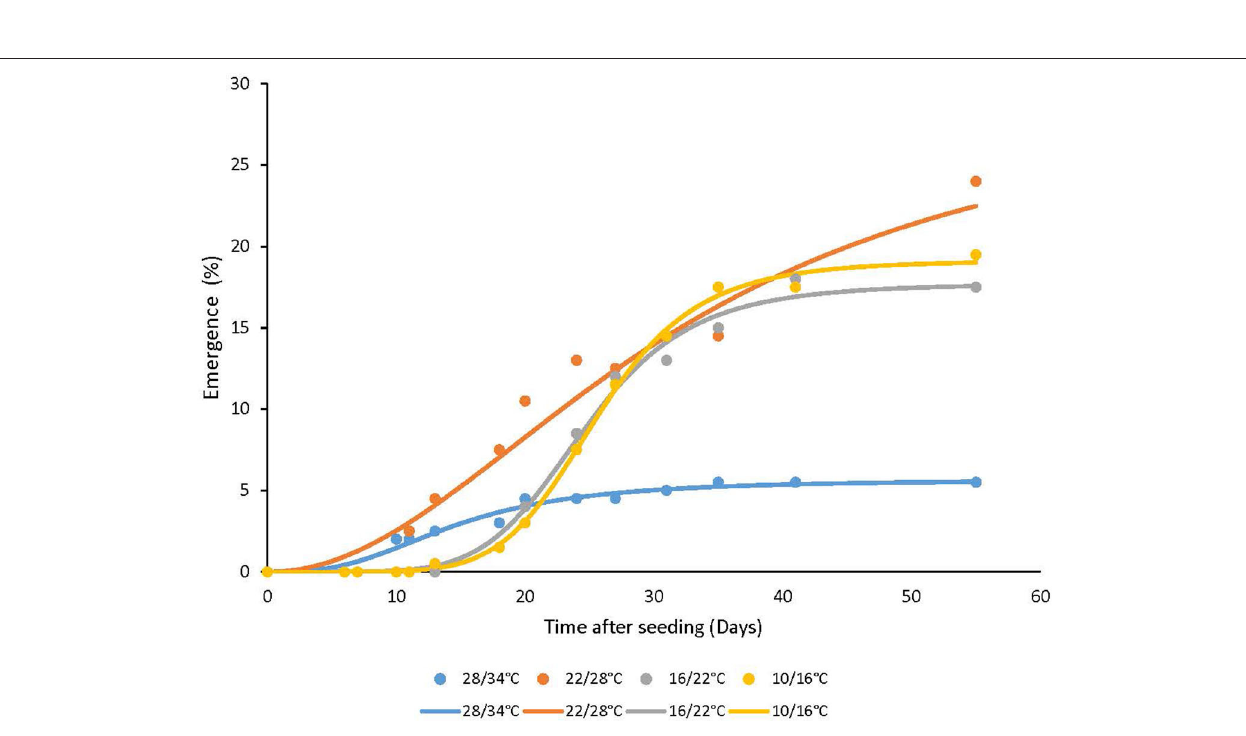
FIGURE 2 | The effect of temperature regimes on the seedling emergence rate of A. confertiflora. Seed placed on the soil surface (0cm seeding depth), 55 DAS. Three-parameter logistic nonlinear regressions between A. confertiflora emergence and time (days) were used. Parameters of the equations of four temperatures regimes are presented in Table 2